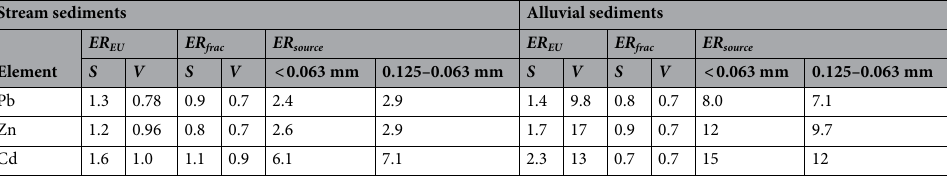
Table 3. Enrichment ratios for stream and alluvial sediments. S Savinja River, V Voglajna River, ER EU enrichment ratio of median elemental levels according to the European stream sediment median elemental levels, ER frac enrichment ratio of median elemental levels in 0.125–0.063 mm fraction compared to the median elemental levels in < 0.063 mm fraction, ER source enrichment ratio of elemental levels downstream of the main source of the pollution compared to the estimated corresponding geochemical background